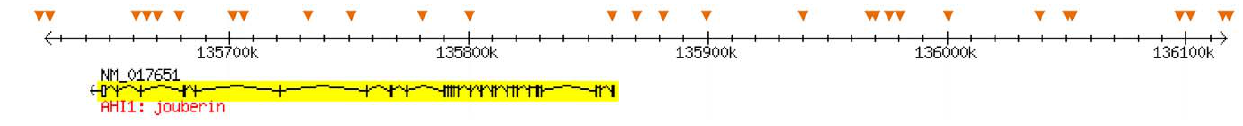
Figure 2. Genomic region and SNPs analyzed in this study. The position of each SNP is indicated with an orange arrow.